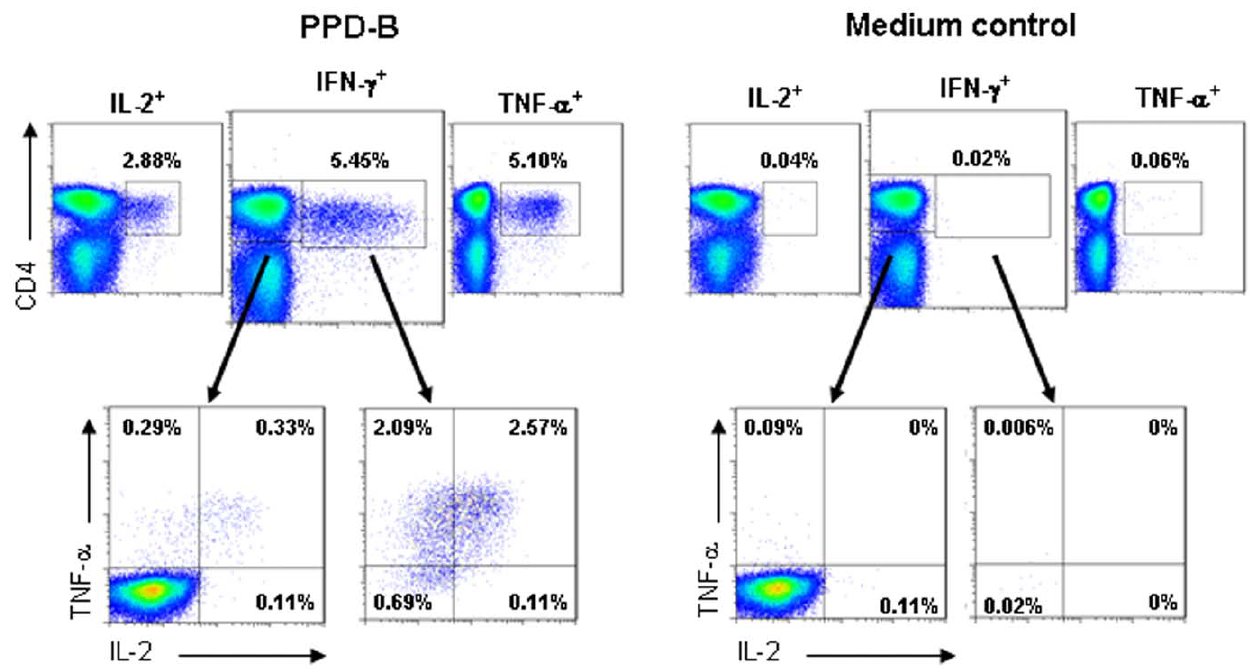
Figure 2. Identification of multifunctional IFN- c , IL-2 and TNF- a CD4 + cells in natural M.bovis infection. PBMC from naturally M. bovis infected cattle were cultured in the presence of either PPD-B or medium and the co-expression of IFN- c , IL-2 and TNF- a determined by ICS flow cytometry. Histograms were gated on singlet, live lymphocytes and then all CD4 + cells analysed for all combinations of cytokine productivity. The upper histograms show the total proportion of CD4 + cells staining for expression of IFN- c , IL-2 or TNF- a following stimulation with PPD-B (left panel) or medium control (right panel). Subgating of the IFN- c + and IFN- c 2 CD4 + cells provides histograms that represent all possible functionalities for the expressing of the 3 cytokines, as shown in the lower histograms. The numbers indicate percentage of CD4 + cells and data are representative of 1 of